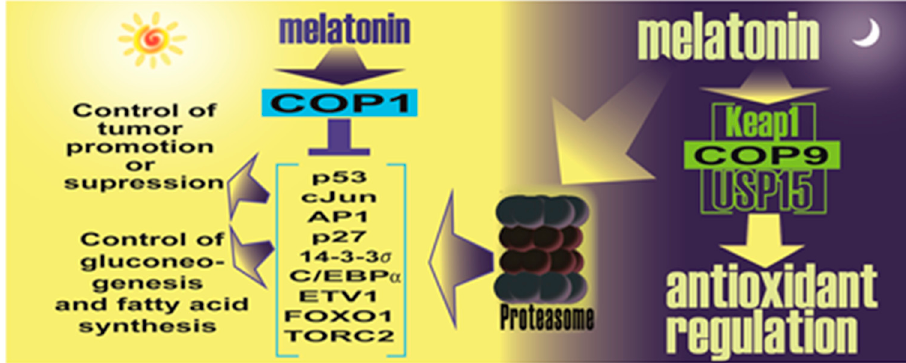
Figure 5. A summary of the theoretical actions of melatonin on constitutive photomorphogenic protein 1 (COP1) as it may relate to cancer. COP1, which we hypothesize is influenced by melatonin, controls the expression of multiple targets in the blue box (check color) thereby impacting tumorigenesis as well as carbohydrate and lipid metabolism. The inclusion of COP9 may potentially relate to melatonin’s antioxidant actions. The presumed direct effect of melatonin on the proteasome is also